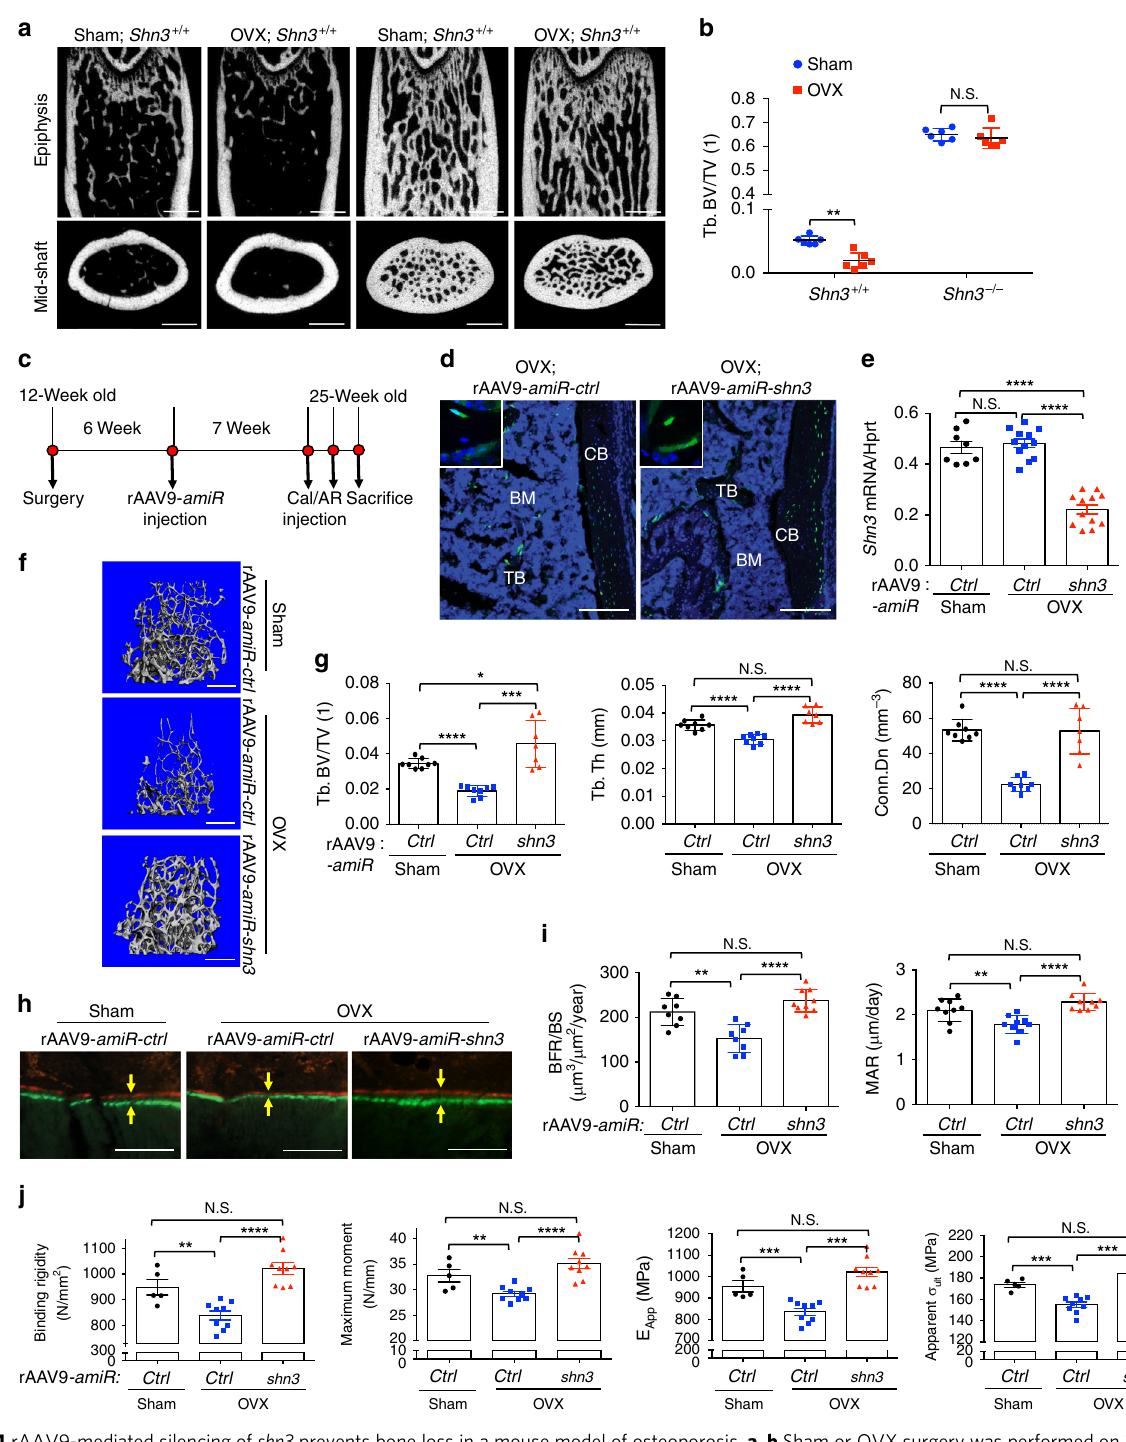
Fig. 4 rAAV9-mediated silencing of shn3 prevents bone loss in a mouse model of osteoporosis. a , b Sham or OVX surgery was performed on 3-month-old female Shn3 + / + and Shn3 − / − mice and 2 months later, femoral trabecular bone mass was assessed by microCT. Representative images of the femur ( a ) and relative BV/TV ( b ) are displayed ( n = 6 per group). c – j Diagram of the study and treatment methods ( c ). Sham or OVX surgery was performed on 3- month-old female mice and 6 weeks later, a single dose of 4 × 10 11 genome copies of rAAV9 carrying amiR-ctrl or amiR-shn3 was i.v. injected. Seven weeks after injection, femurs were cryo sectioned to identify EGFP-expressing cells ( d ). shn3 mRNA levels in tibial bone are displayed after normalization to hprt ( n = 8 – 12 per group) ( e ). Femoral trabecular bone mass was assessed by microCT. Representative 3D reconstruction ( f ) and relative quanti fi cation ( g ) are displayed ( n = 7 – 8 per group). Representative images of calcein/alizarin red labeling ( h ) and relative histomorphometric quanti fi cation of BFR/BS and MAR ( i ). Arrows indicate the distance between calcein and alizarin red labeling. Femoral biomechanical properties, including bending rigidity, bending moment, apparent bending modulus, and apparent bending stress were quanti fi ed ( n = 5 – 9 per group) ( j ). Scale bars: a , f 1 mm; d 250 μ m; and h 50 μ m. Values represent mean ± SD: N.S., not signi fi cant; * P < 0.05; ** P < 0.01; *** P < 0.001; and **** P < 0.0001 by an unpaired two-tailed Student ’ s t -test ( b ) and one-way ANOVA test ( e , g , i , j